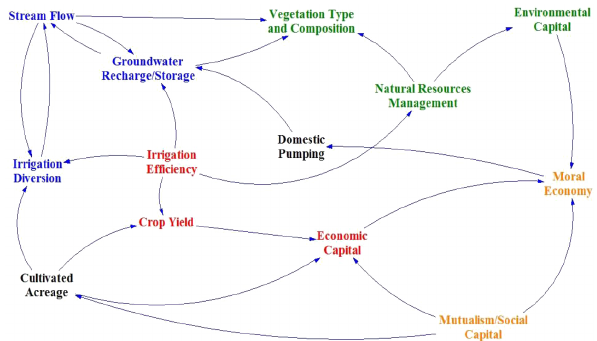
Figure 14. Essential causal loop diagram with key variables for modeling. Black variables are critical elements integrating across multiple subsystems, while colors are primary to individual disci-